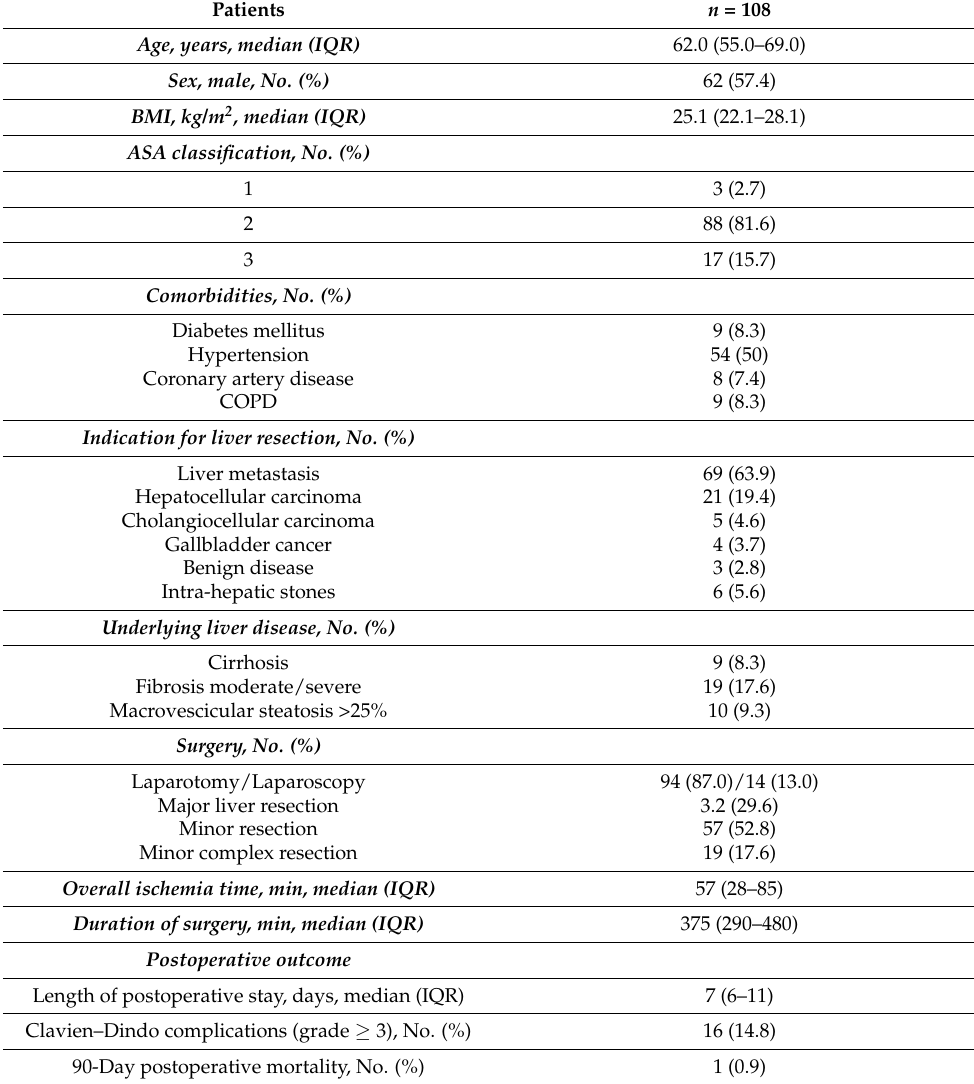
Table 1. Clinical and surgery characteristics of the 108 investigated patients.